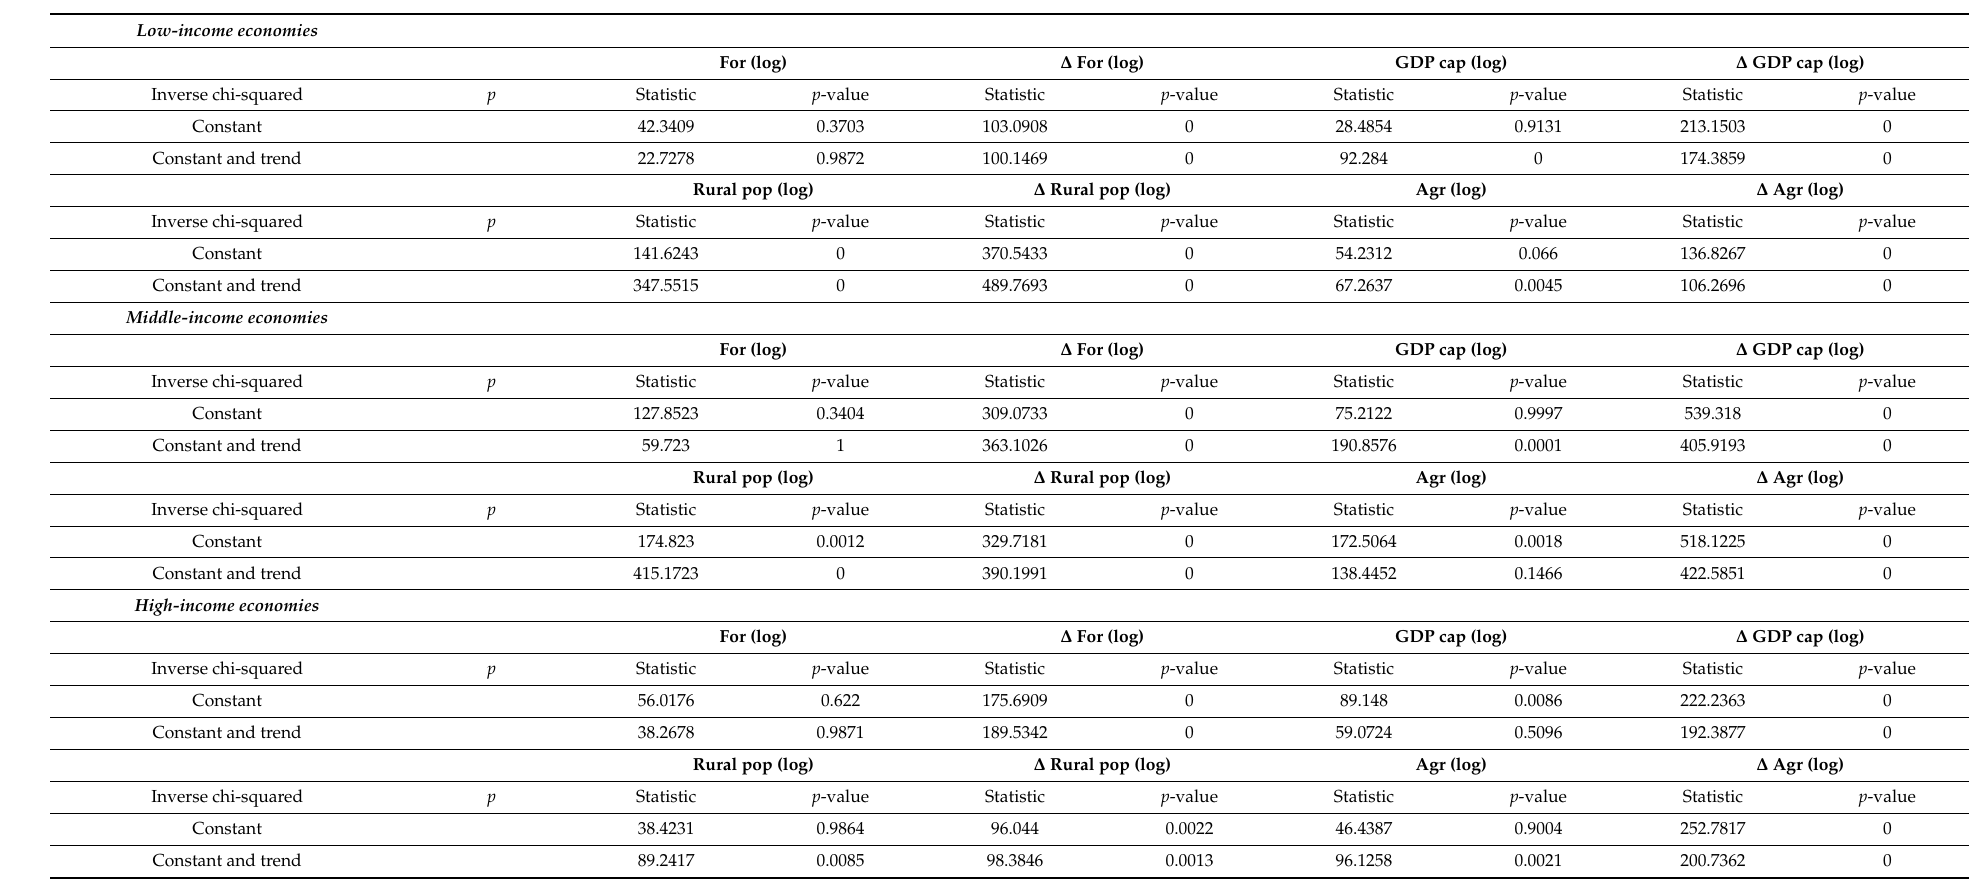
Table A12. Unit root tests, income